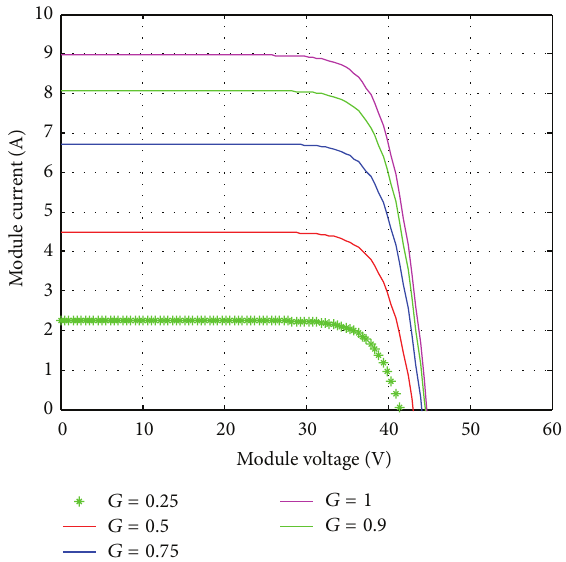
Figure 3: I - V characteristic of the PV module under different